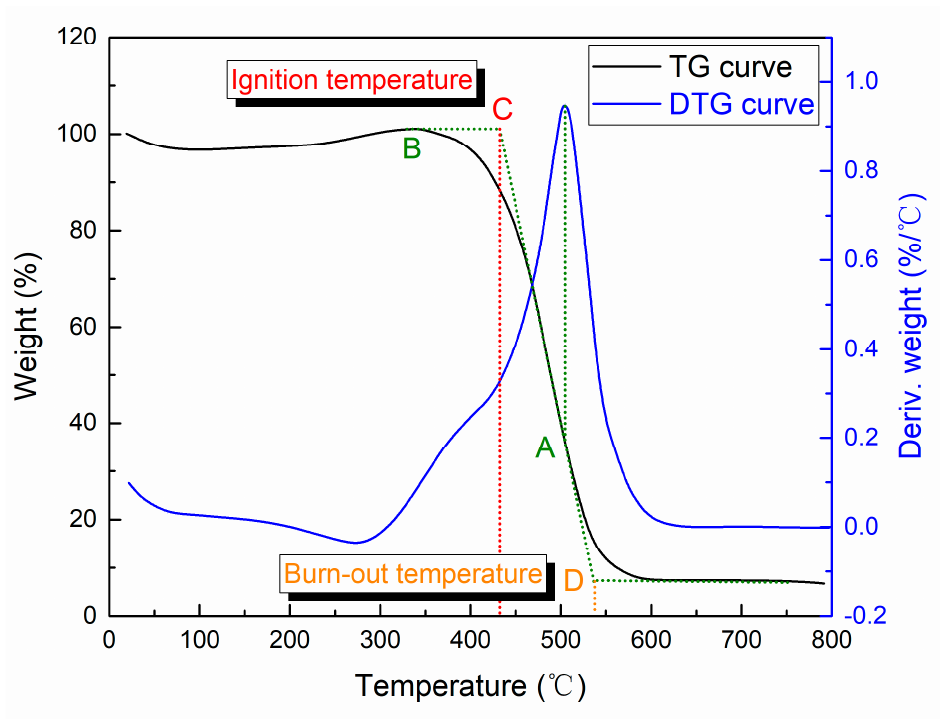
Figure 8. Definitions of ignition temperature and burn-out temperature.